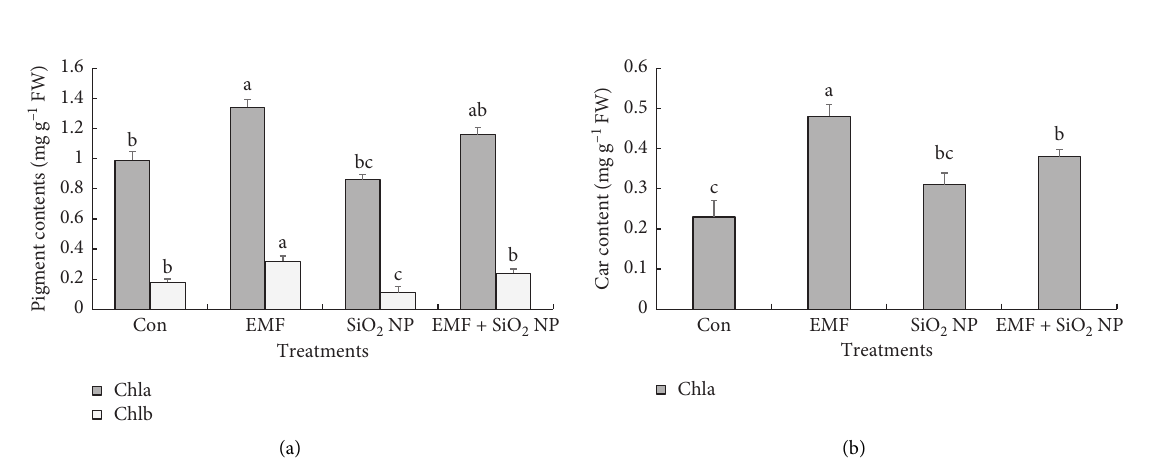
Table 1: Effect of EMF and SiO 2 NPs on some growth parameters and protein content in A. gilanica seedlings. Parameters